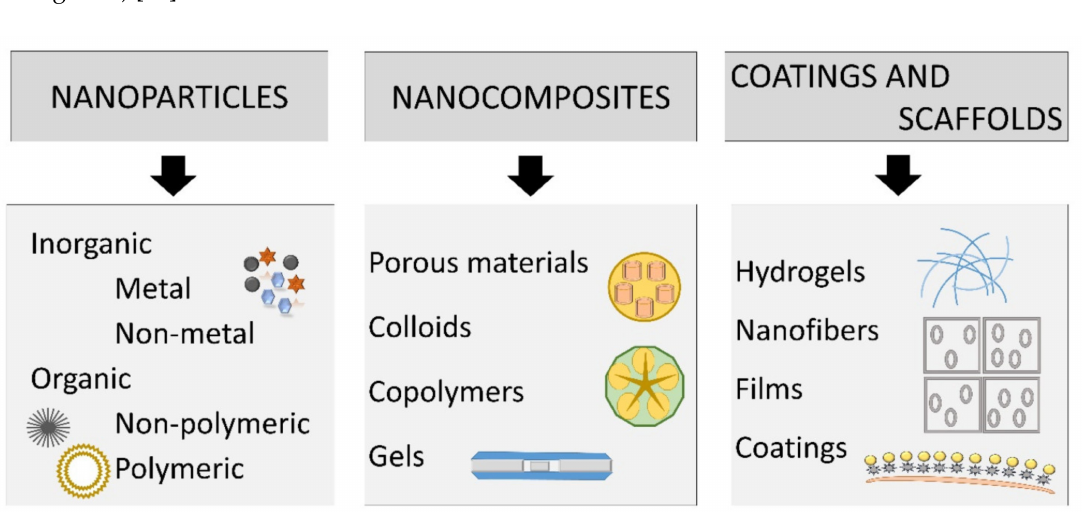
Figure 3. Main types of nanomaterials can be used for wound treatment [58]. Reprinted from an open-access